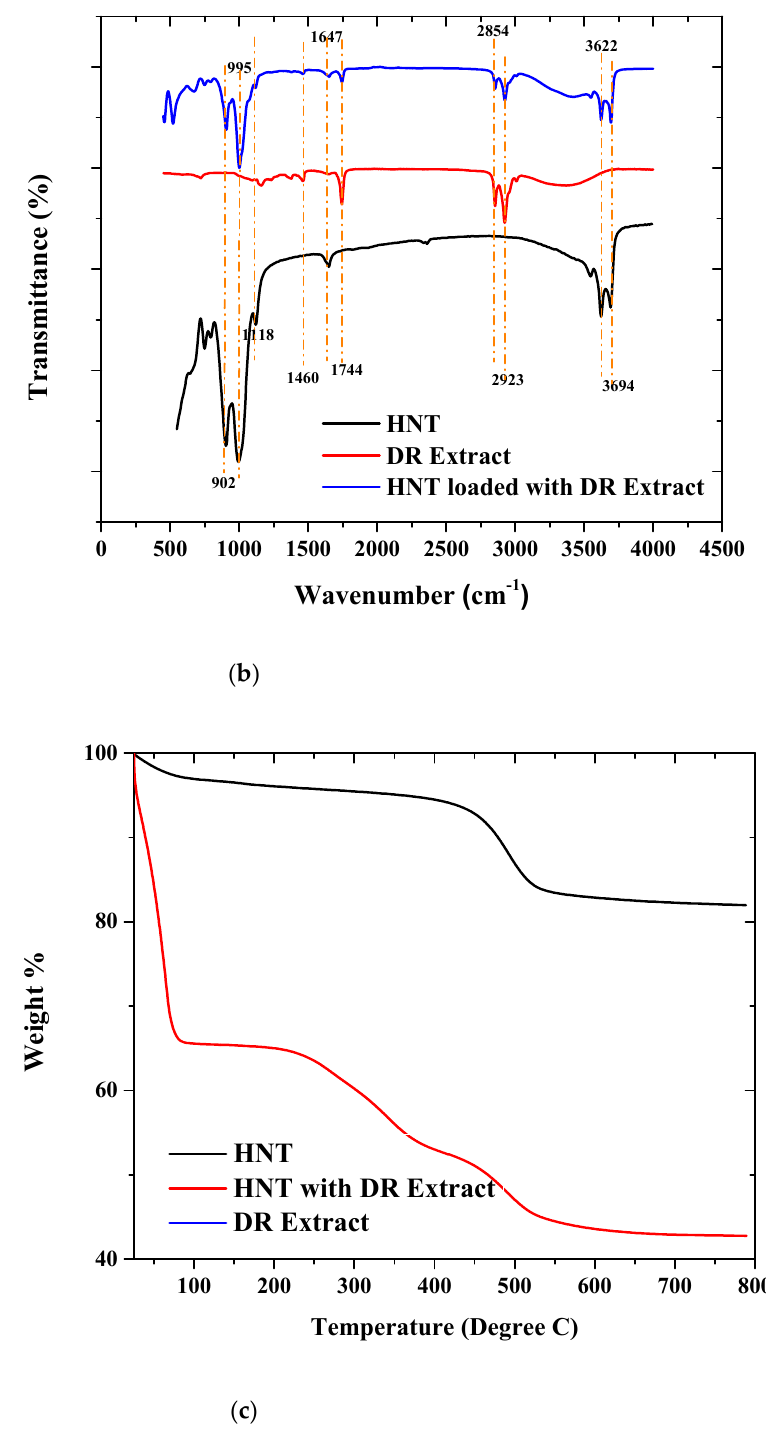
Figure 1. ( a ) X-ray diffractometry (XRD) spectra of halloysites nanotubes (HNT) and HNT loaded with the Dioclea Reflexa (DR) extract. ( b ) Fourier transform infrared (FTIR) spectra of HNTs and loaded HNTs with plant metabolites. ( c ) TGA of HNT and HNT loaded with DR extract.